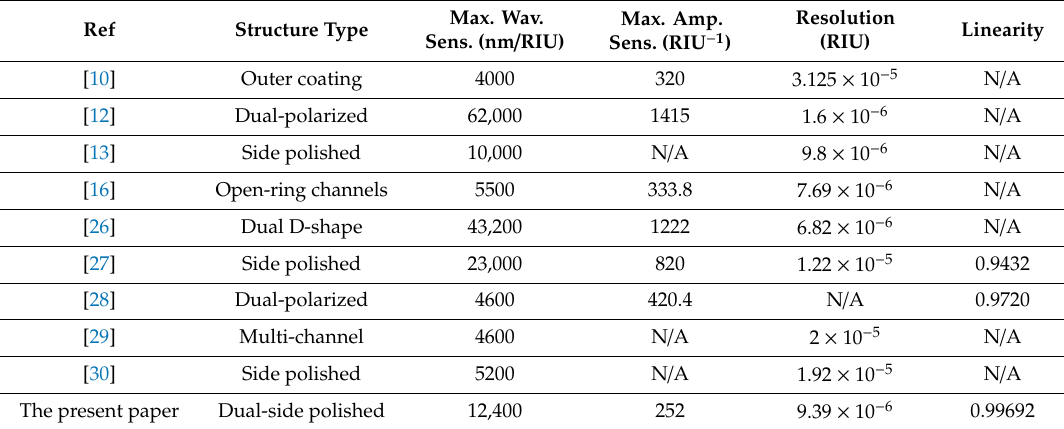
Table 1. Performance comparison of the proposed sensor and previous